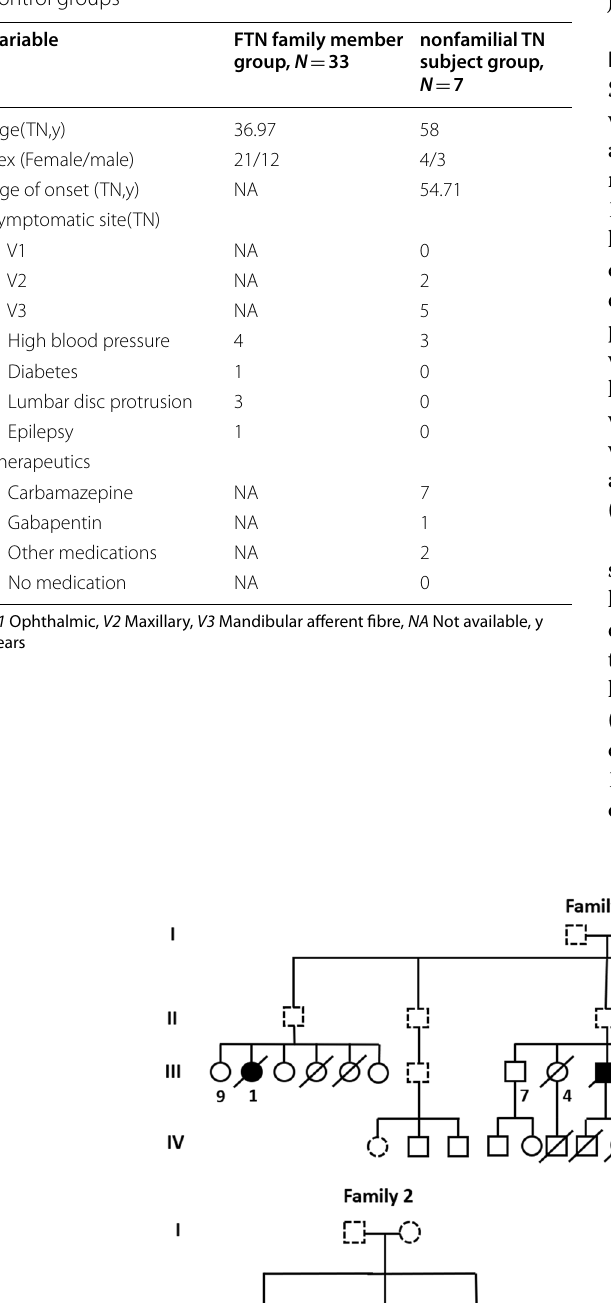
Table 2 The demographic data and baseline characteristics of control groups